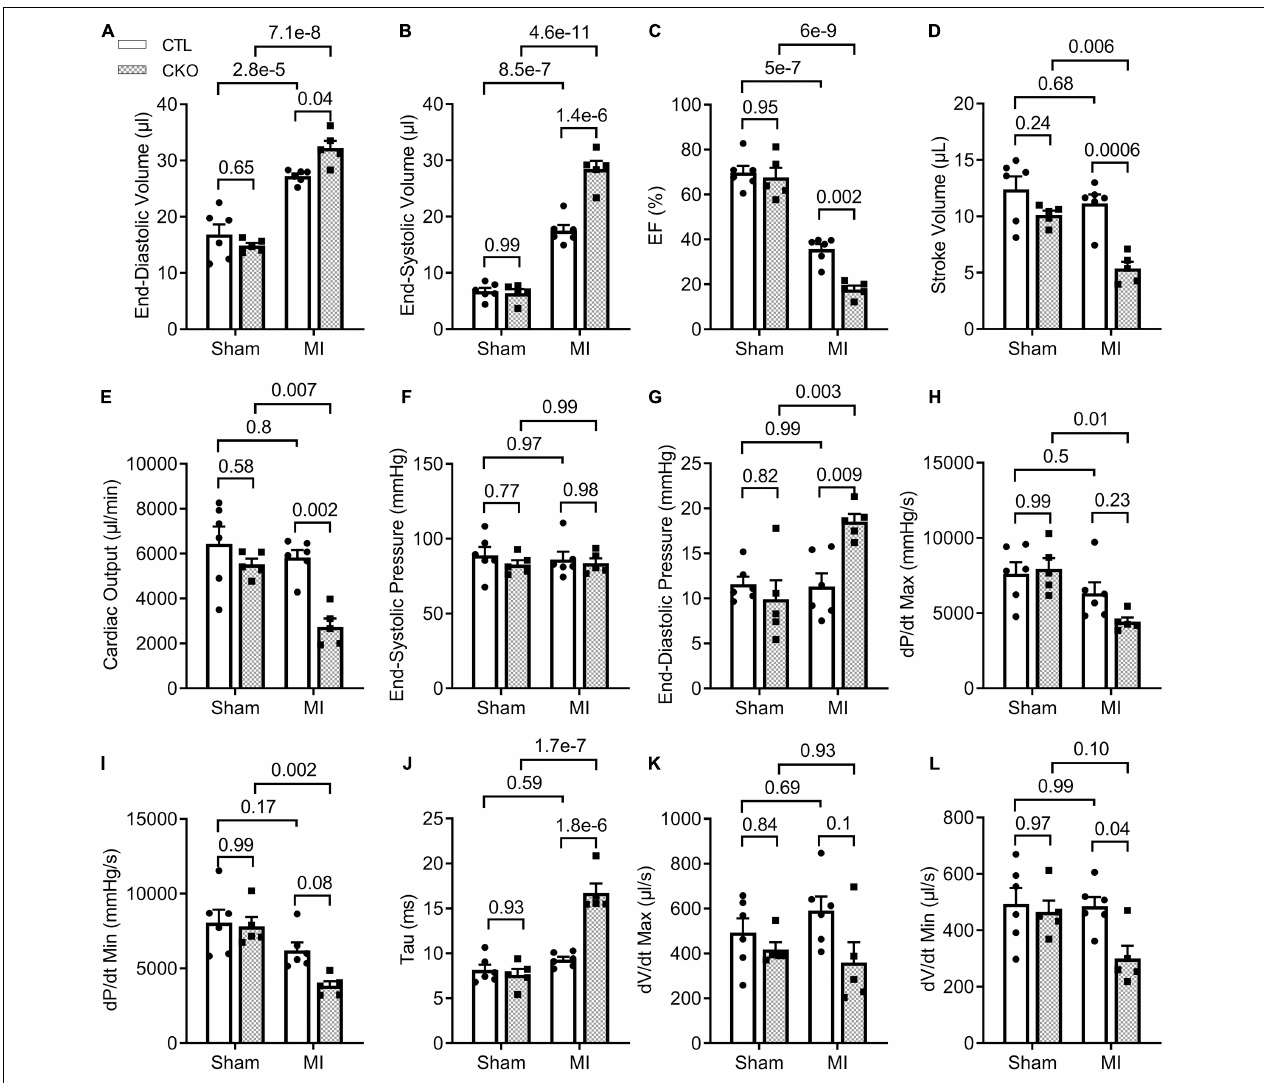
FIGURE 6 | LV P-V loop analyses 28 days post-MI. CTL and CKO mice were subjected to sham surgery or LAD ligation as described in Figure 3 . Parameters shown in panels (A–L) are derived from LV P-V loops collected 28 days post-MI. Each dot represents an individual mouse. For the CTL genotype, n = 6 mice (2 males + 4 females) for both Sham and MI groups; for the CKO genotype, n = 5 mice (2 males + 3 females) for both sham and MI groups. The p -value of the pair-wise comparison shown above the bracket is derived from two-way ANOVA followed by Tukey’s